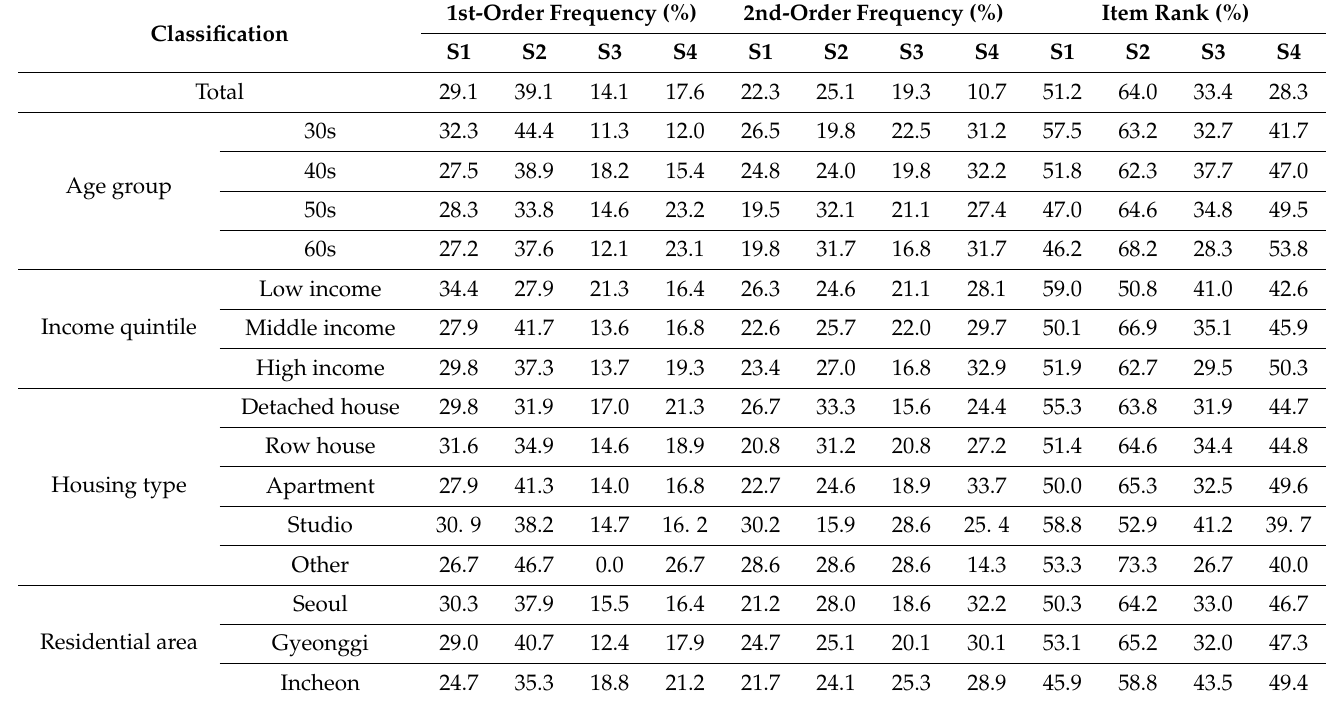
Table 12. Demographic characteristics of item ranking in the solutions to the problems caused by street